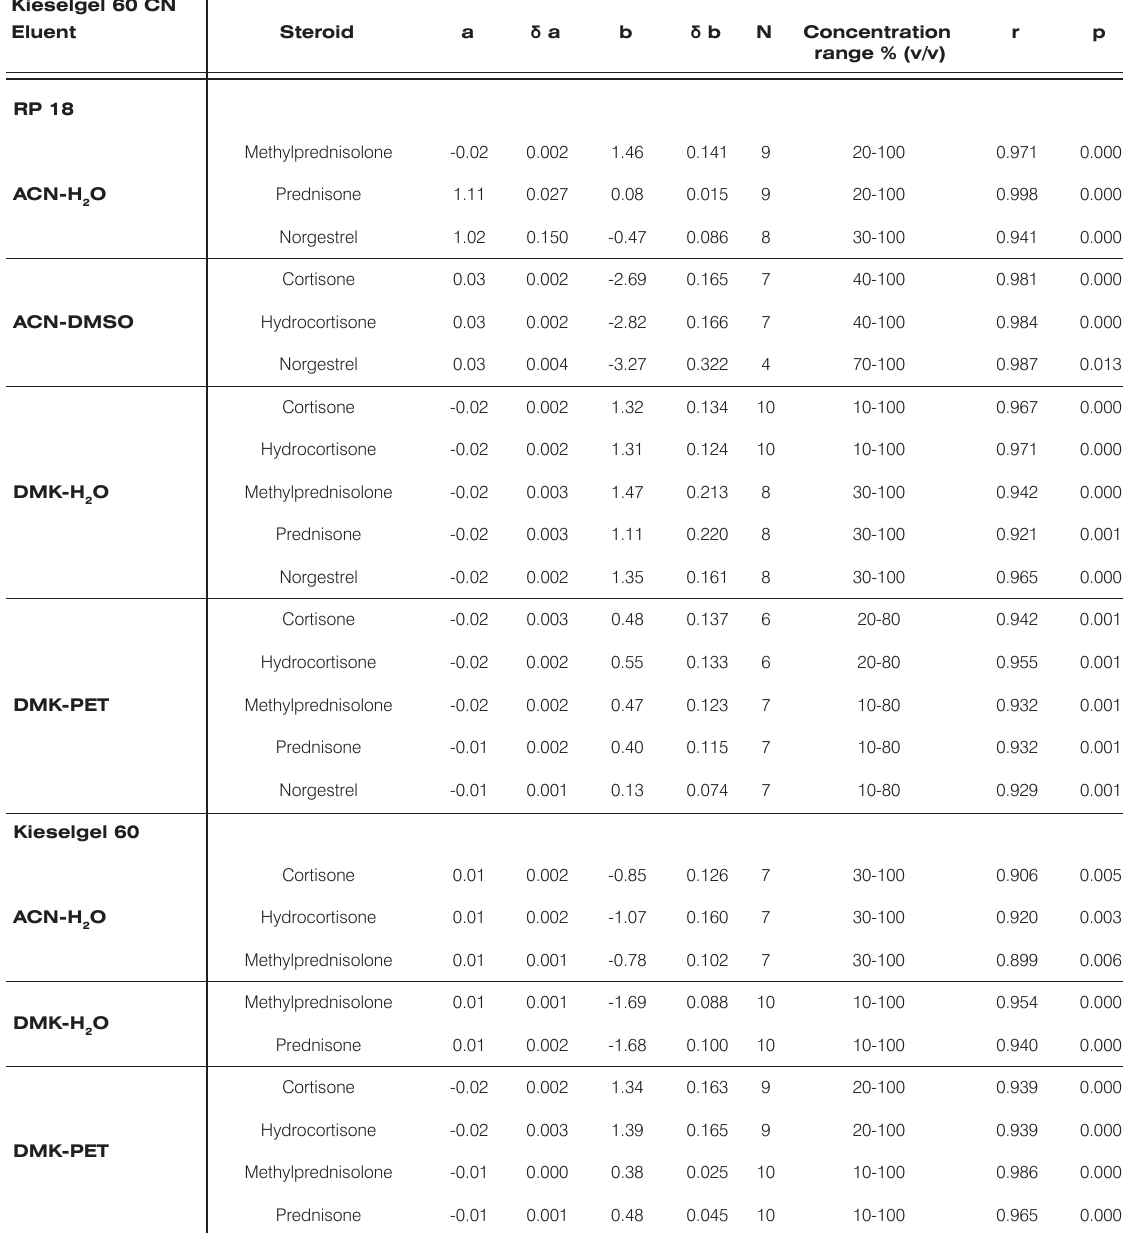
nonaqueous mobile phases (acetonitrile-methanol and acetone-petroleum ehter) (Fig. 3) are much smaller than in aqueous mobile phases because norgestrel by applying both non-aqueous eluents grouped in quadrant I (+, +) next to methylprednisolone and prednisone using acetonitrile-methanol as